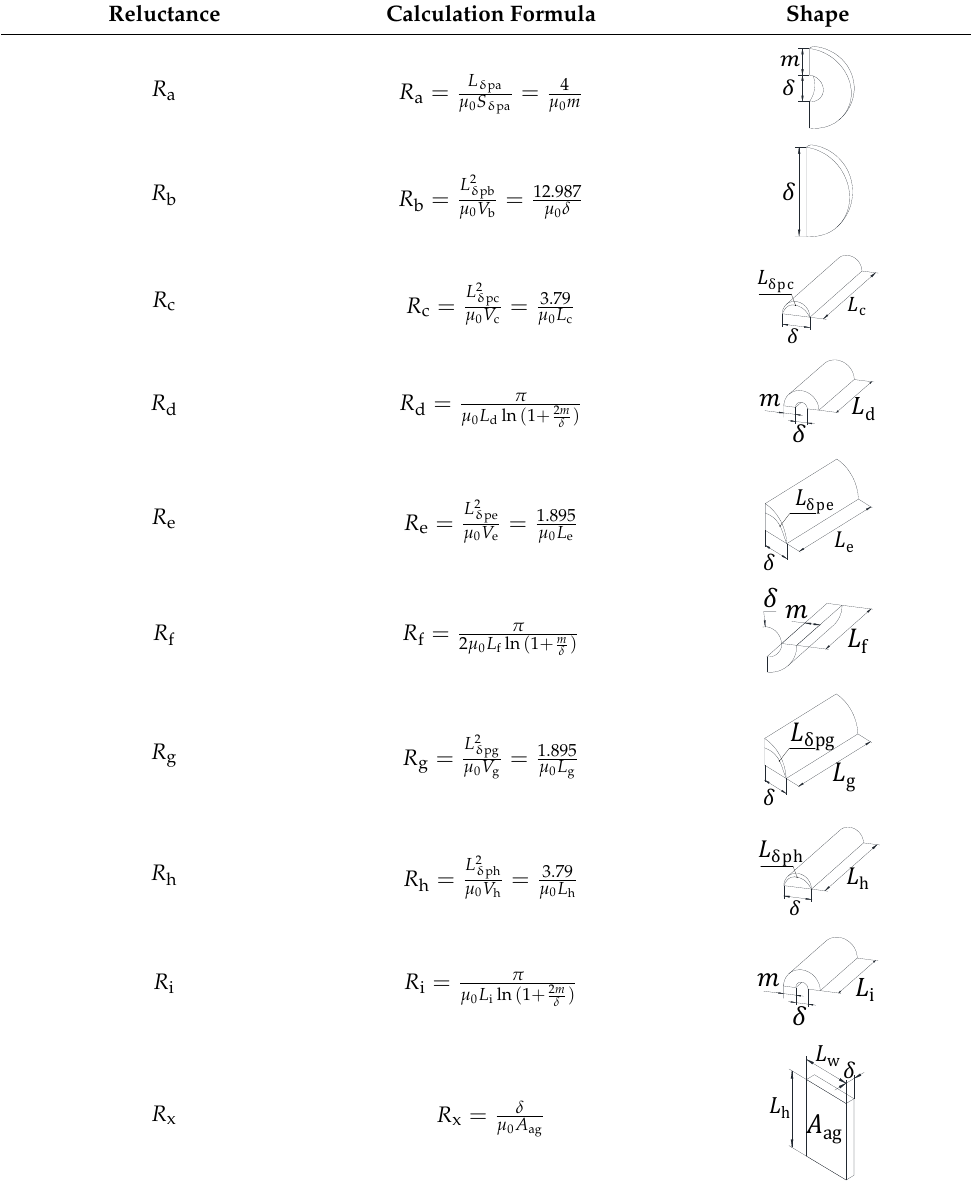
Table 1. Reluctance calculation of segmented magnetic flux tubes [28].